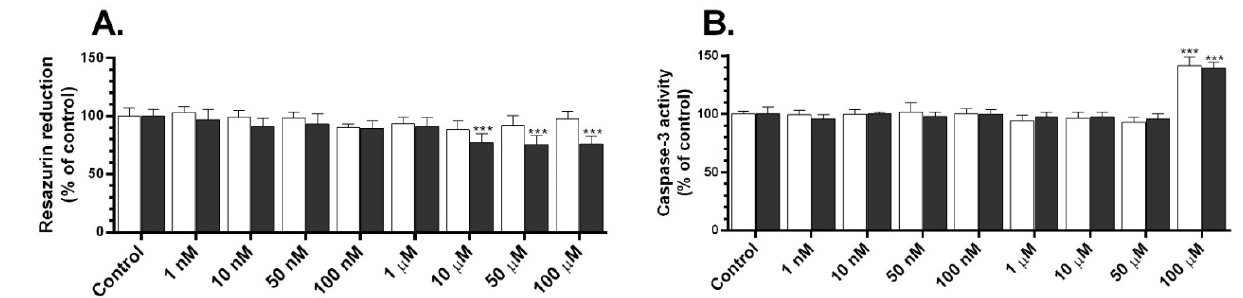
Figure 1. Effect of 1, 10, 50, and 100 nM and 1, 10, 50, and 100 µM of TBC on the level of resazurin reduction ( A ) and caspase-3 activity ( B ) in GC-1 spg cell line after 24 (white bars) and 48 (black bars) h exposure. Data are expressed as means ± SD of three independent experiments, each conducted in six replicates per treatment group. *** p < 0.001 vs. the vehicle control.